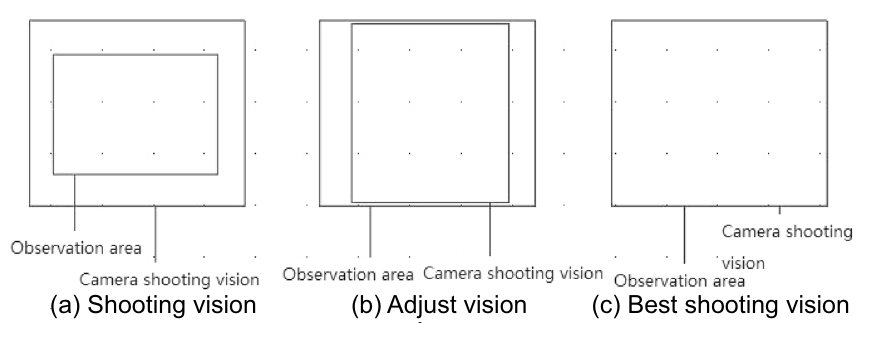
Figure 8. Best shooting